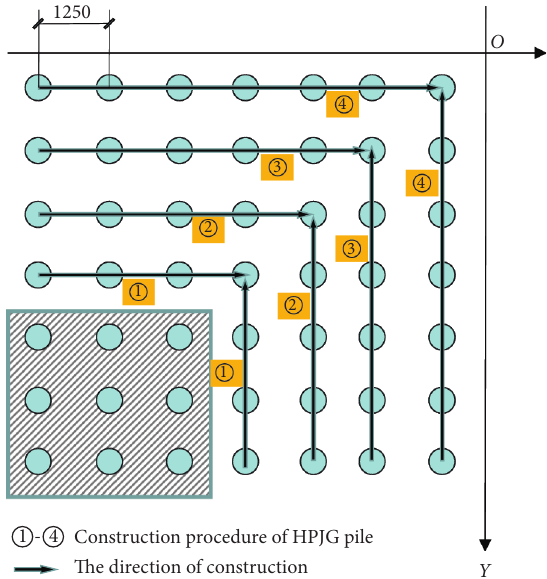
Figure 10: Construction procedure of HPJG